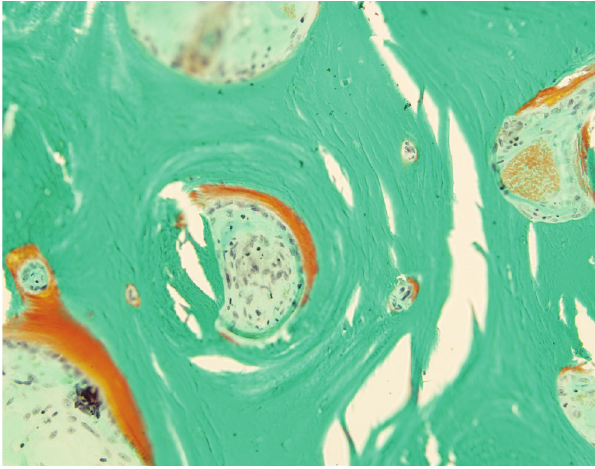
FIGURE 8 - Intraoral radiograph taken 20 weeks after surgery shows incorporation of the graft into the segmental defect. Cat 10 of Group 2.